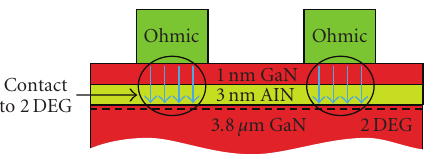
Figure 1: Optimised TLM processing summary for unprotected and unpassivated AlN/GaN HEMT samples. Processing includes (a) sample cleaning with acetone, isopropanol,and deionised water, (b) deoxidation, (c) Ohmic metallisation, (d) Ohmic annealing, and (e) TLM measurements.